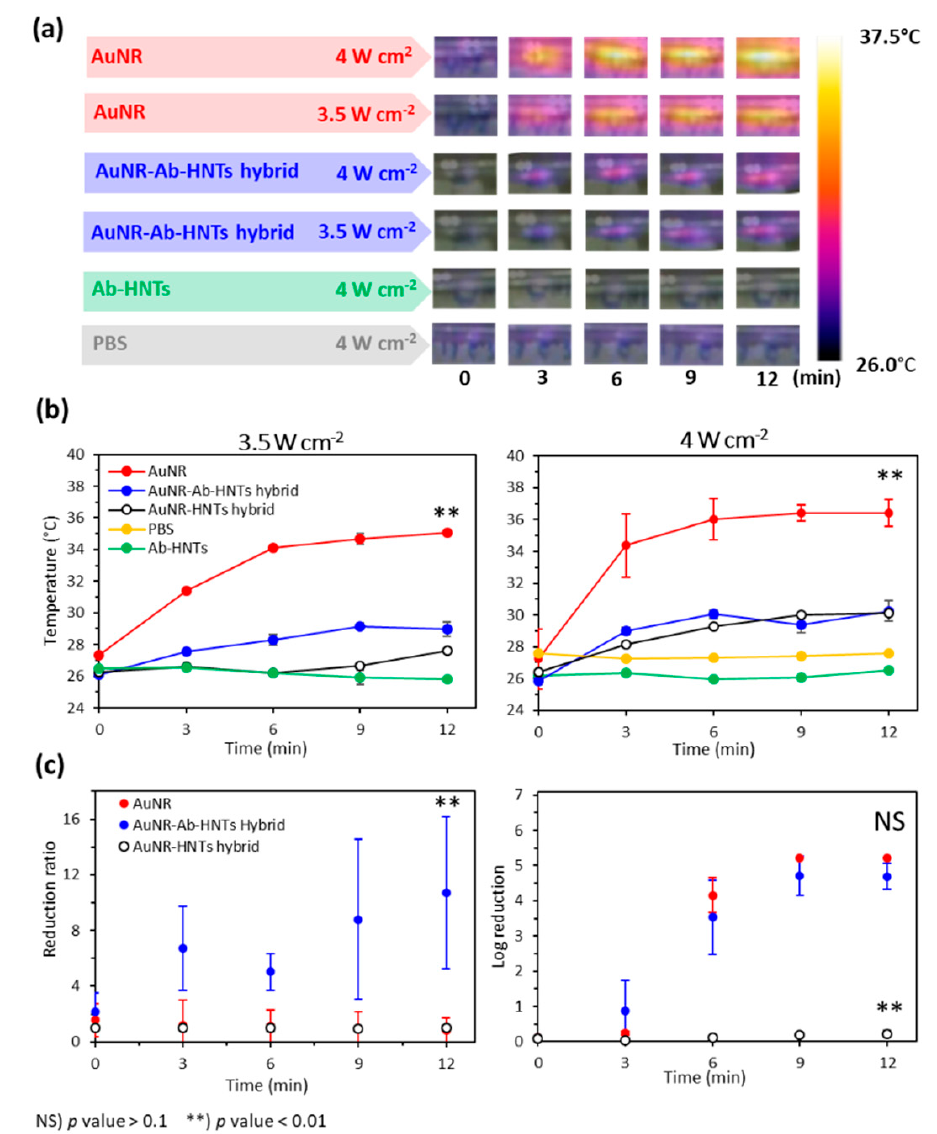
Figure 4. Antibacterial photothermal treatment (APTT) of AuNR-Ab-HNTs hybrids compared with free AuNRs. ( a ) Examples of thermal camera images. ( b ) Temperature measurements using the thermal camera, as a function of irradiation (808 nm) time at a power density of 3.5 and 4 W cm − 2 (left and right panel, respectively) for AuNR-Ab-HNTs hybrids (blue), free AuNRs (red), Ab-HNTs without AuNRs (green), AuNR-HNTs hybrid without antibody (black with hollow marker), and PBS control (yellow). ( c ) Antibacterial effect measured by plate count as a function of irradiation (808 nm) and time, at a power density of 3.5 and 4 W cm − 2 for left and right panels, respectively (color scheme similar to all other results in this figure). Error bars represent SD ( n = 3). NS: p -value > 0.1; **: p -value < 0.01 according to a two-tailed t -test.